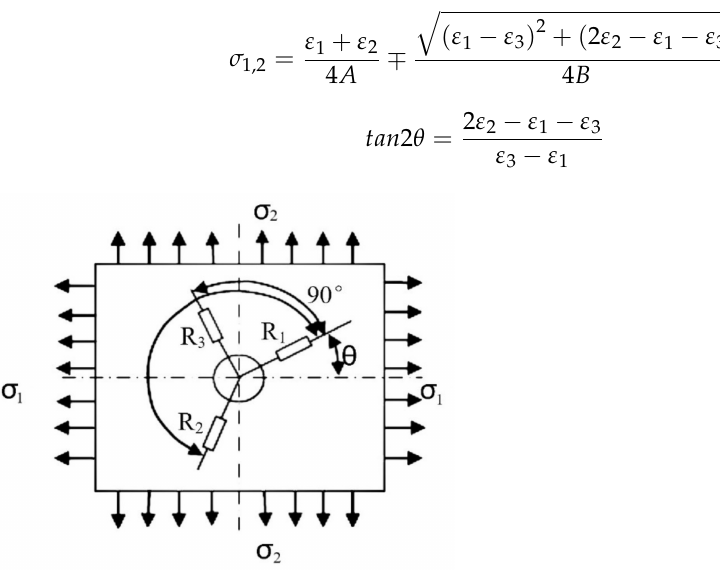
Figure 2. Principle of measuring residual stress via the blind hole